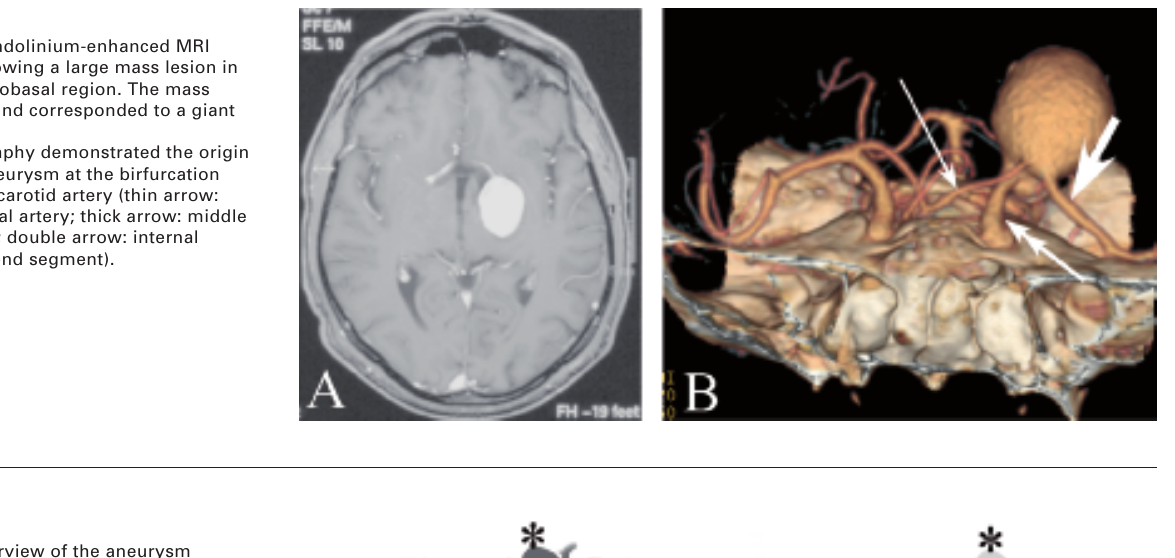
A Schematic overview of the aneurysm location (*) in respect to extracranial and intracranial arteries B Schematic view of the aneurysm and its first intracranial to intracranial ELANA bypass (*) C Schematic view of the aneurysm and its second extracranial to intracranial ELANA bypass (*)